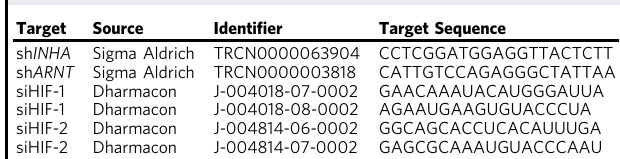
Table 1 shRNA and siRNA sequences.